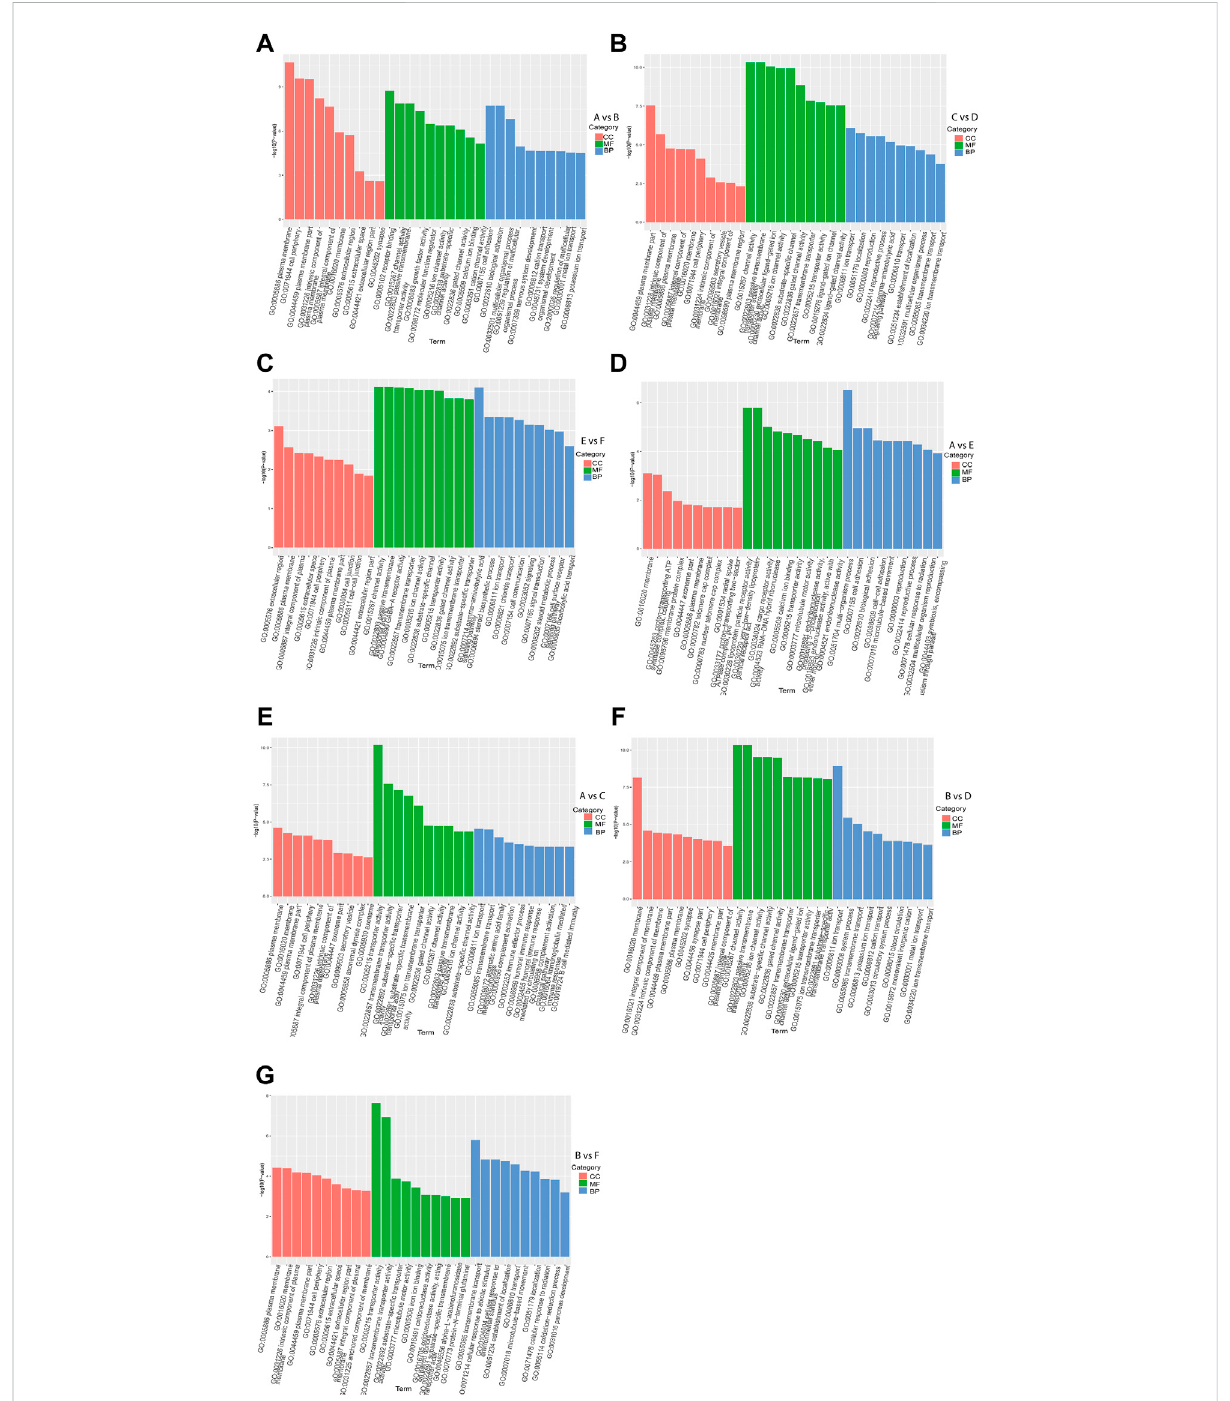
FIGURE 2 GO functional enrichment analysis of DEGs. The x -axis represents the secondary GO terms, the y -axis represents the -log10 p -value of enrichmentofeachterm.Intra-breedcomparisonsbetweenfemalesandmalesincludeAvs.B. (A) ,Cvs.D. (B) ,andEvs.F. (C) .Comparisonsbetween Muleducksand Muscovy ducks orJindingducks ofsame sexinclude A vs.E. (D) ,A vs. C. (E) ,Bvs.D. (F) ,and B vs.F. (G) . BP, biological processes; CC, cellular component; MF, molecular